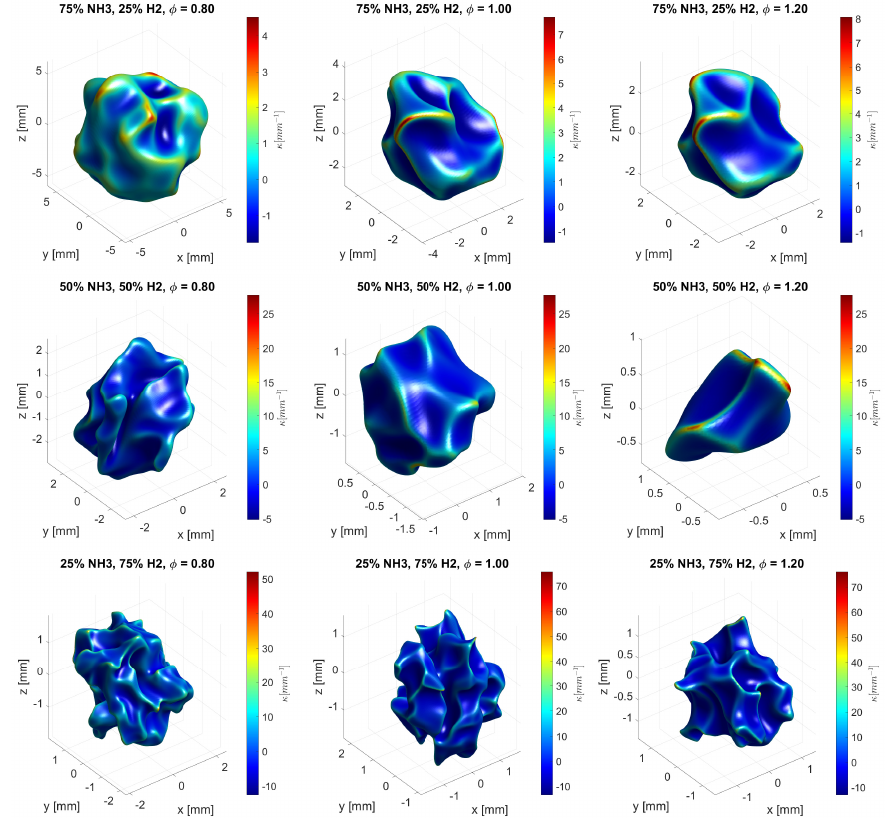
Figure 2. Flame structure of all the cases after one eddy turnover time. The iso-surface is taken at the inner layer temperature calculated from a one-dimensional freely propagating flat flame. The surface is coloured with curvature values.